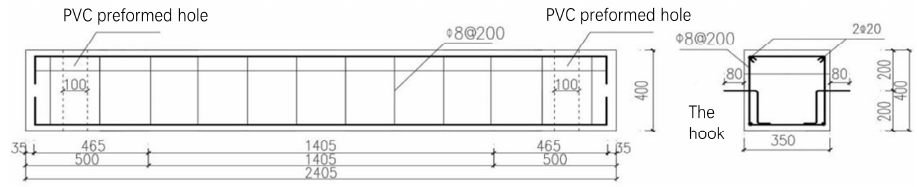
Figure 3. Geometric size and rebar arrangement of the base beam. (Unit of mm).